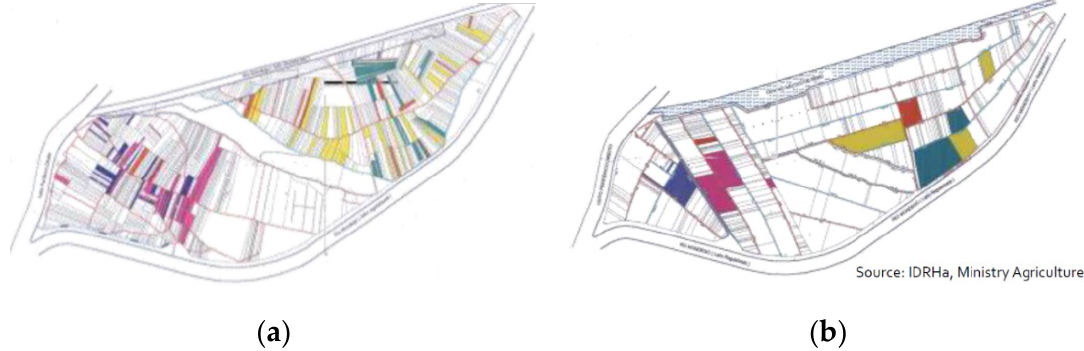
Figure 6. Land plots before ( a ) and after ( b ) the land consolidation process (taken from [38]).